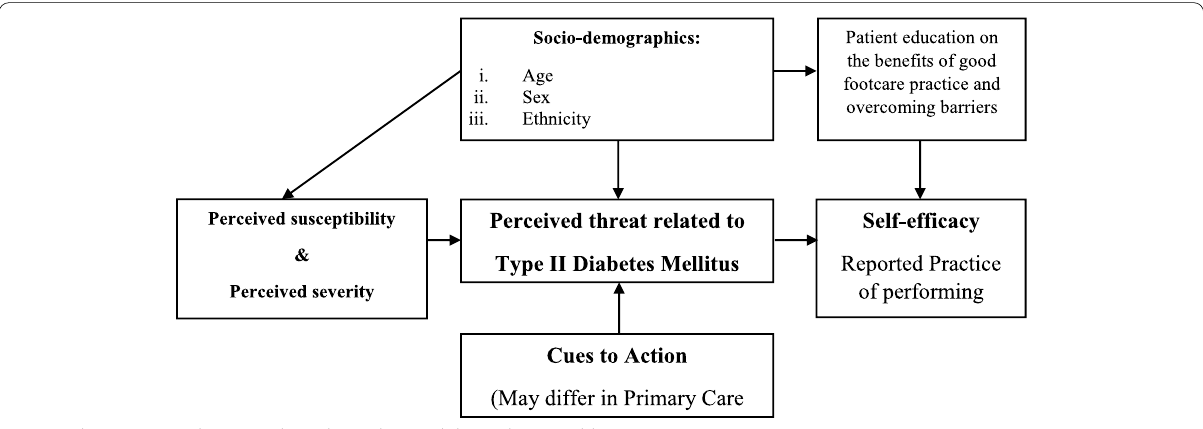
Fig. 2 The association between the independent and dependent